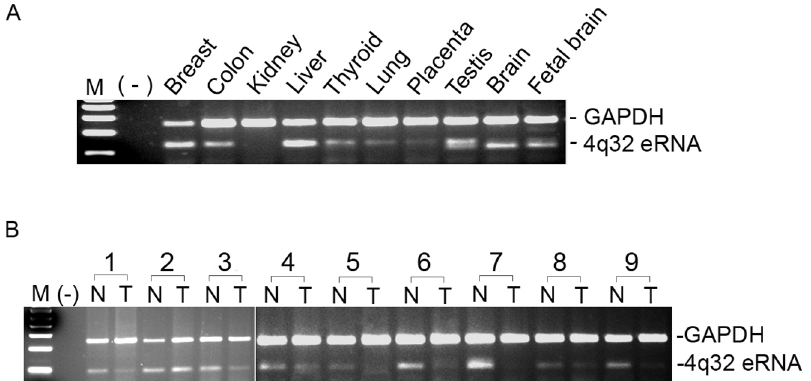
Figure 5. The 4q32 eRNA is expressed in multiple tissues and shows strong downregulation in thyroid tumors. (A) Detection of the 4q32 eRNA in normal human tissues. (B) Semi-quantitative assay of the 4q32 eRNA in paired tumor and unaffected tissue from 9 PTC patients. Total RNA was used for cDNA synthesis; GAPDH was used as an internal control. The primers for the amplicons of the eRNA and GAPDH are provided in Supplementary Table 2.